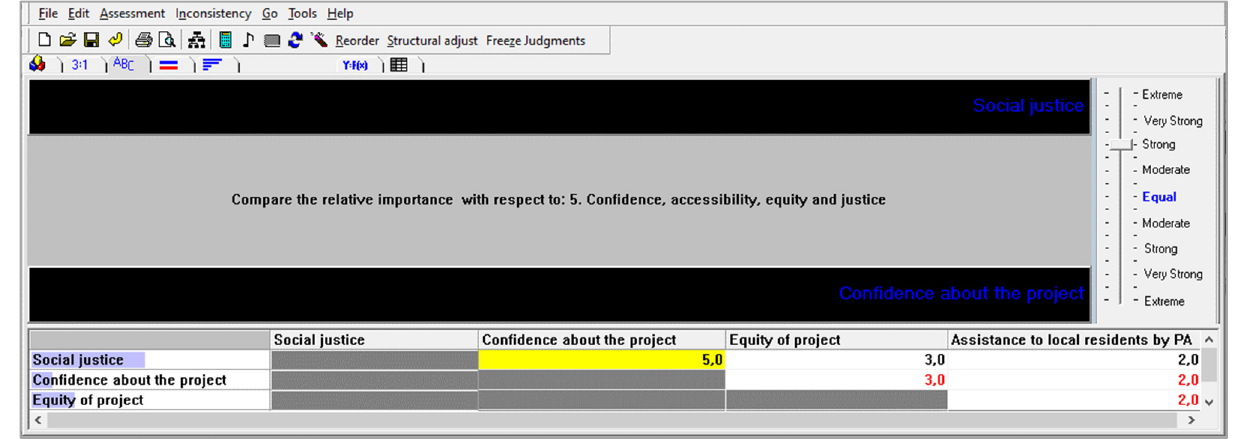
Figure 6. Matrix of the pairwise comparison of the category criteria “5. Confidence, accessibility, equity and justice”.